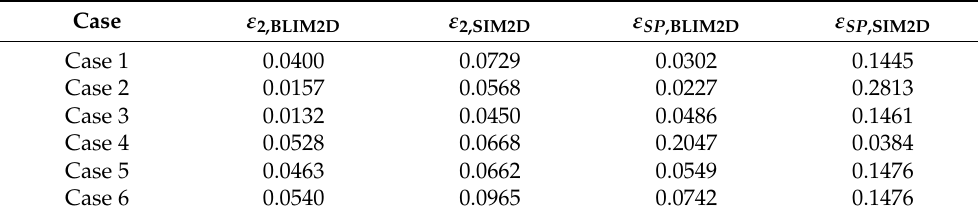
Table A2. Relative errors in h tc in the laminar area for the six cases of Table A1. L2-norm